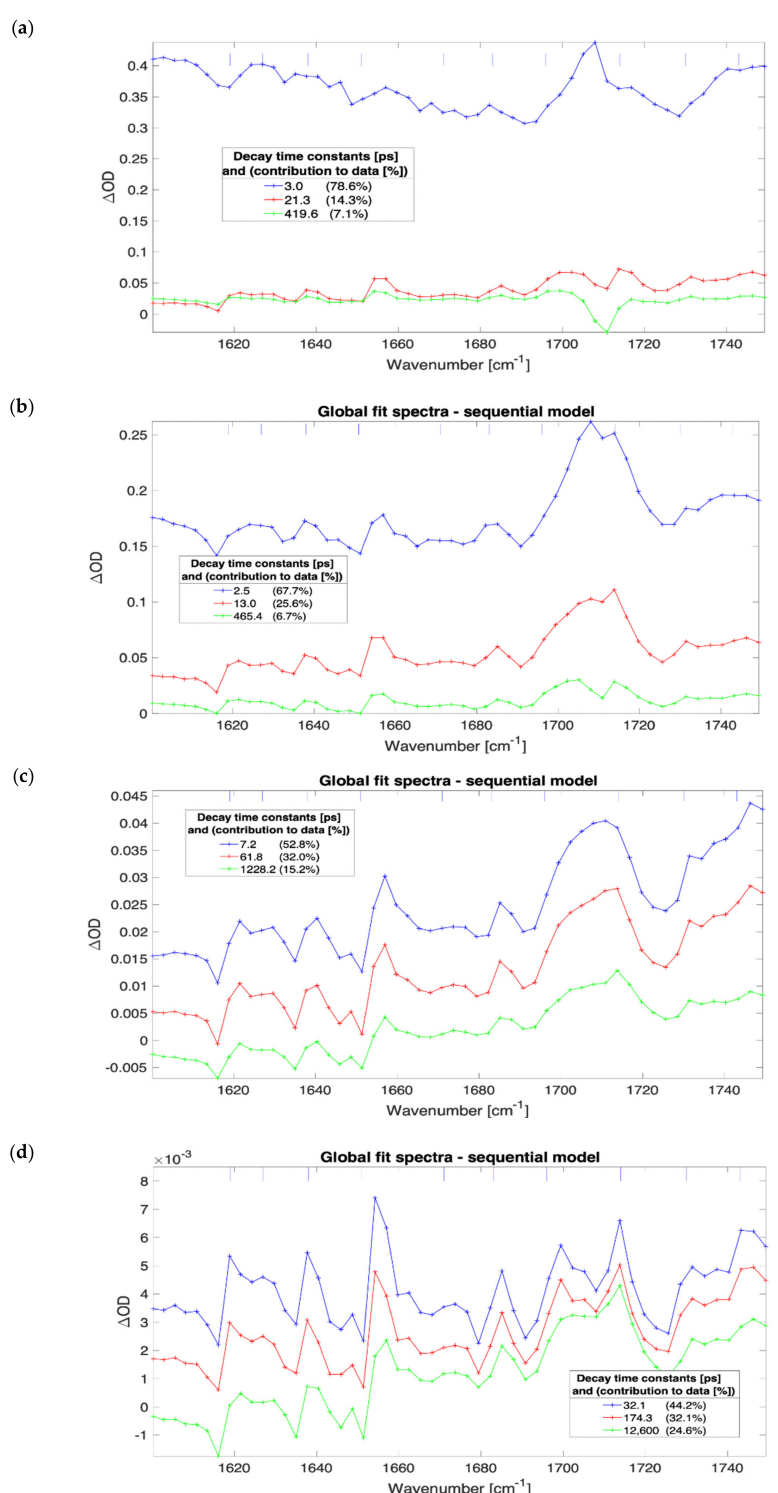
Figure 2. Results of three compartments sequential global fit to data for 600 nm thick film of (FAPbI 3 ) 0.97 (MAPbBr 3 ) 0.03 . The irradiance and SVD time constants; 4.5 × 10 10 W/cm 2 , 3.0 ps, 21.3 ps, and 419.6 ps ( a ); 7.1 × 10 9 W/cm 2 , 2.5 ps, 13.0 ps, and 465.4 ps ( b ); 9.1 × 10 8 W/cm 2 , 7.2 ps, 61.8 ps, and 1228.2 ps ( c ); 9.1 × 10 7 W/cm 2 , 32.1 ps, 174.3 ps, and 12,600.0 ps ( d